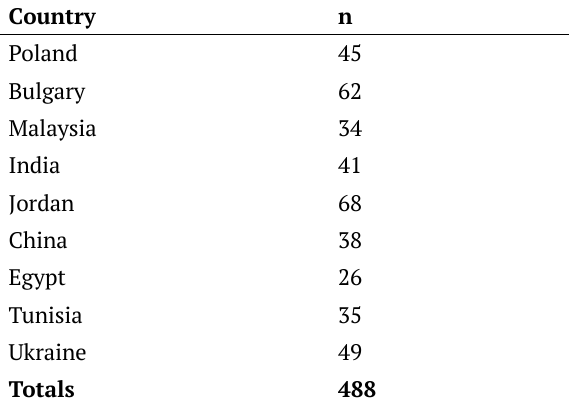
Table 1. Distribution of study